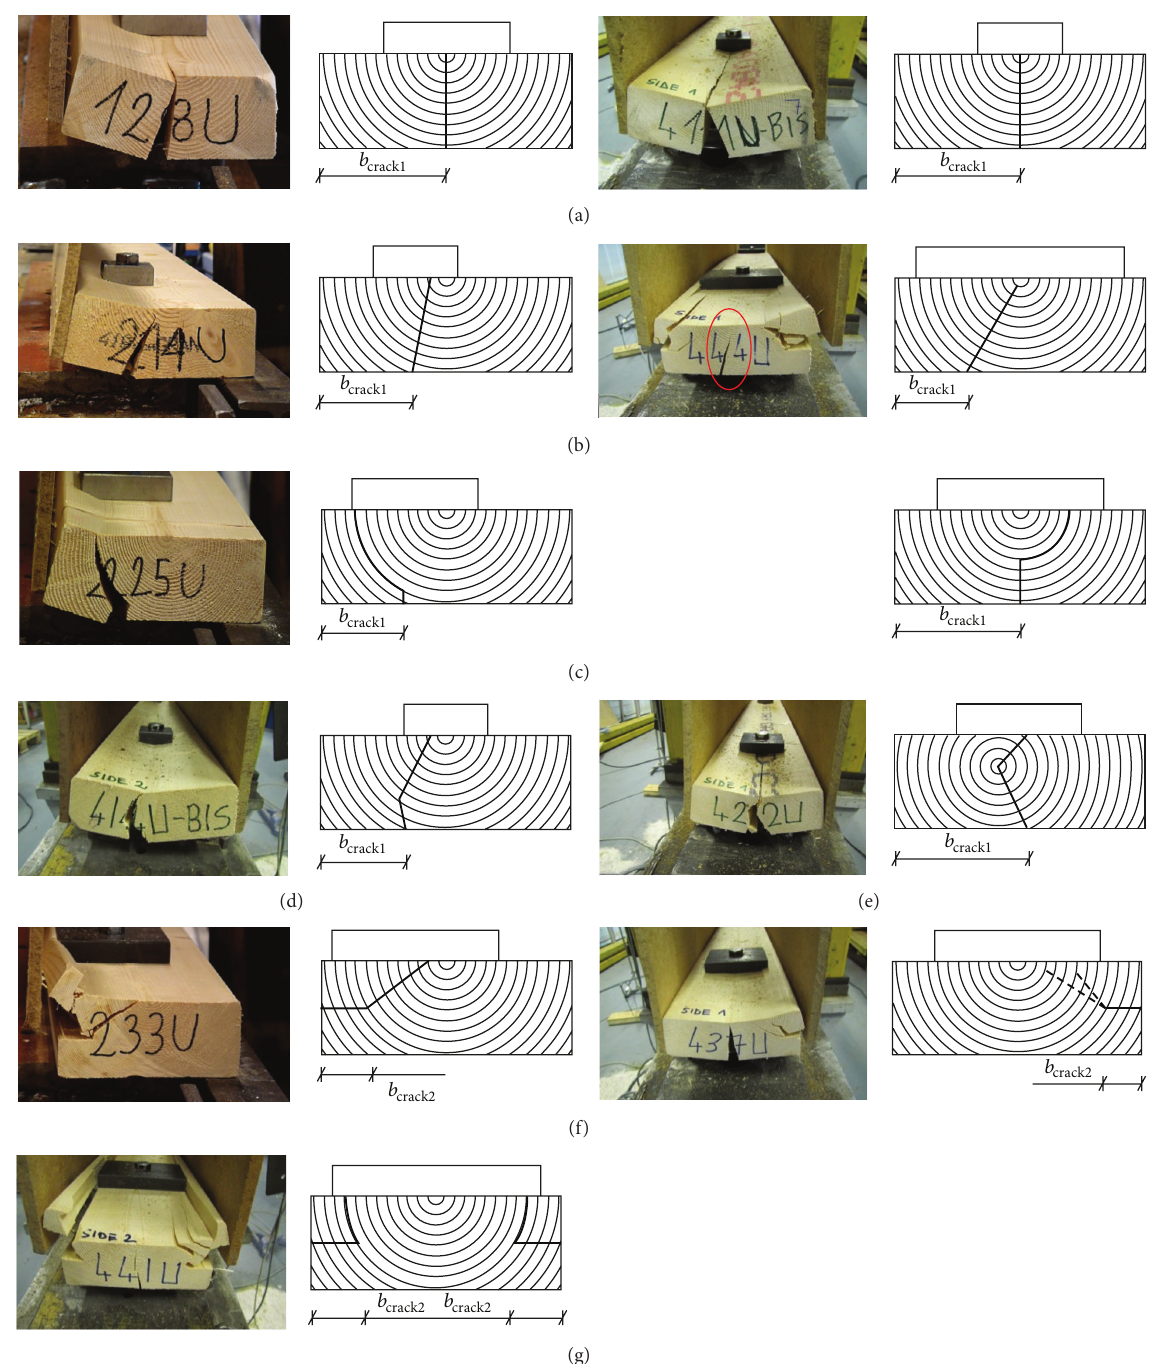
Figure 3: Crack development for bottom rail with pith oriented upwards (PU). (a) Mode 1 crack developing in a straight line, starting and propagating vertically at the centre of the bottom rail; (b) mode 1 crack developing in an oblique line initiating at the bottom surface of the bottom rail at a vertical position close to the edge of the washer and propagating towards the pith; (c) mode 1 crack developing in a straight line for a certain length and then following the annual rings; (d) mode 1 crack developing in an unusual direction, probably due to a weaker crack plane; (e) mode 1 crack developing towards the pith (pith in an unusual position); (f) mode 2 crack starting horizontally and then propagating vertically; and (g) mode 2 crack horizontally and then propagating vertically following the annual